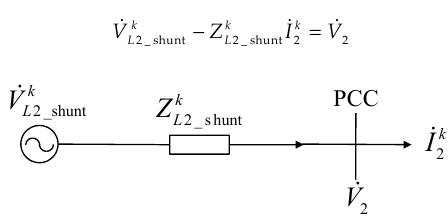
Figure 4. Negative sequence equivalent circuit viewed from feeder k .